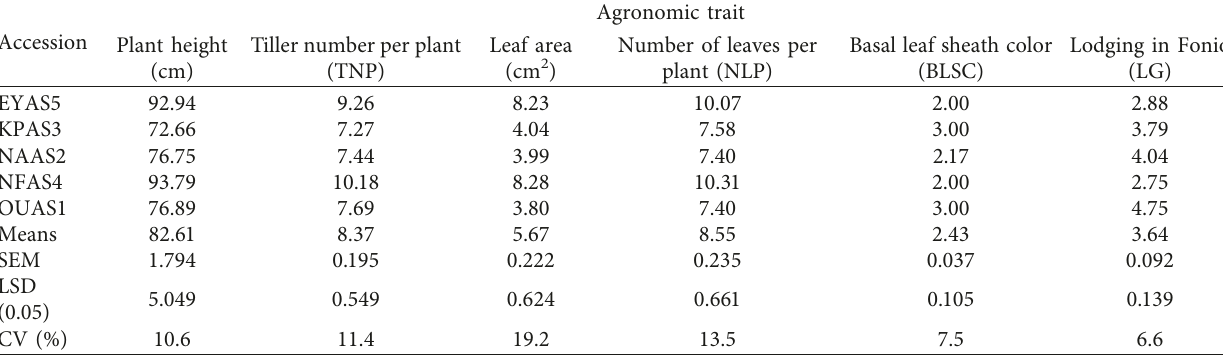
Table 2: Effect of accession on shoot growth, leaf development, and lodging phenomenon in Fonio.